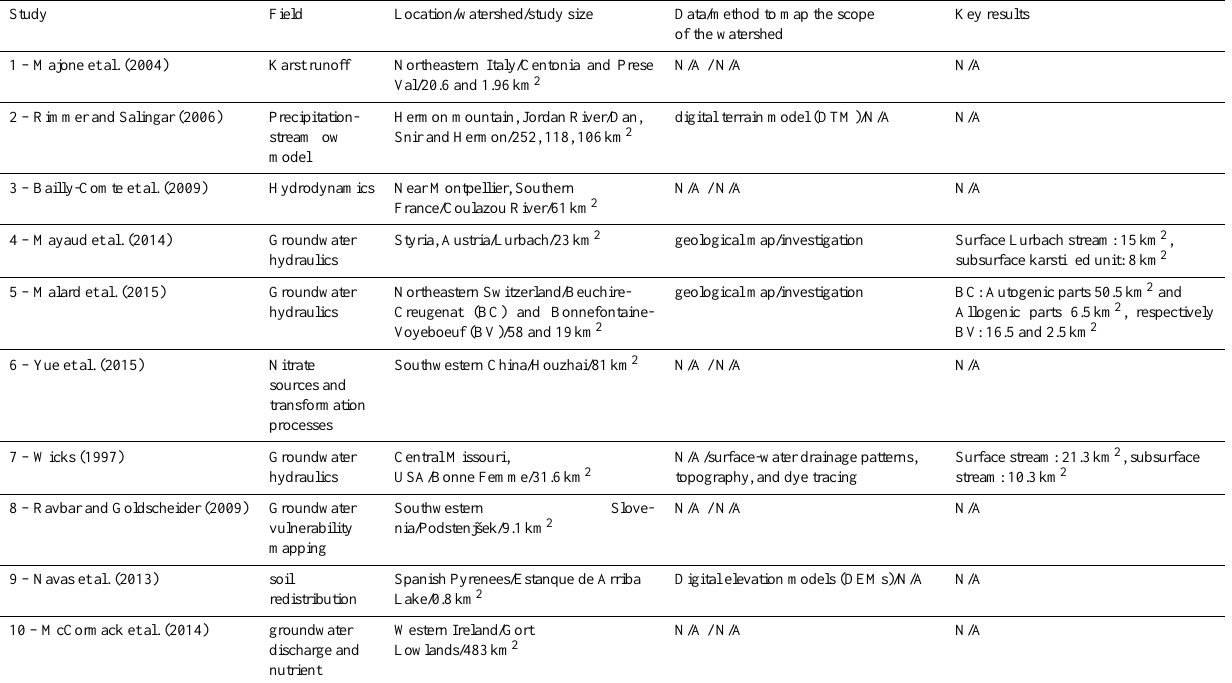
Table 1. Summary of relevant field studies based on watershed scale in karst areas. Not all papers illustrated data and method to map the scope of the studied watershed and these are denoted with “N/A” representing “not applicable” in the relevant part of the “Data/method to map the scope of the watershed” column. The “Key results” column, the accuracy of the scope of the watershed is identified. Many studies do not make an assessment, and N/A directly follows the code in such